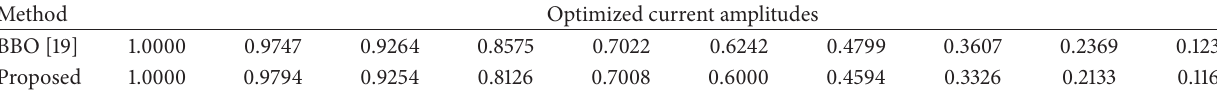
Table 12: Optimized current amplitudes of the positive half of the 20-element array of Example 7 .